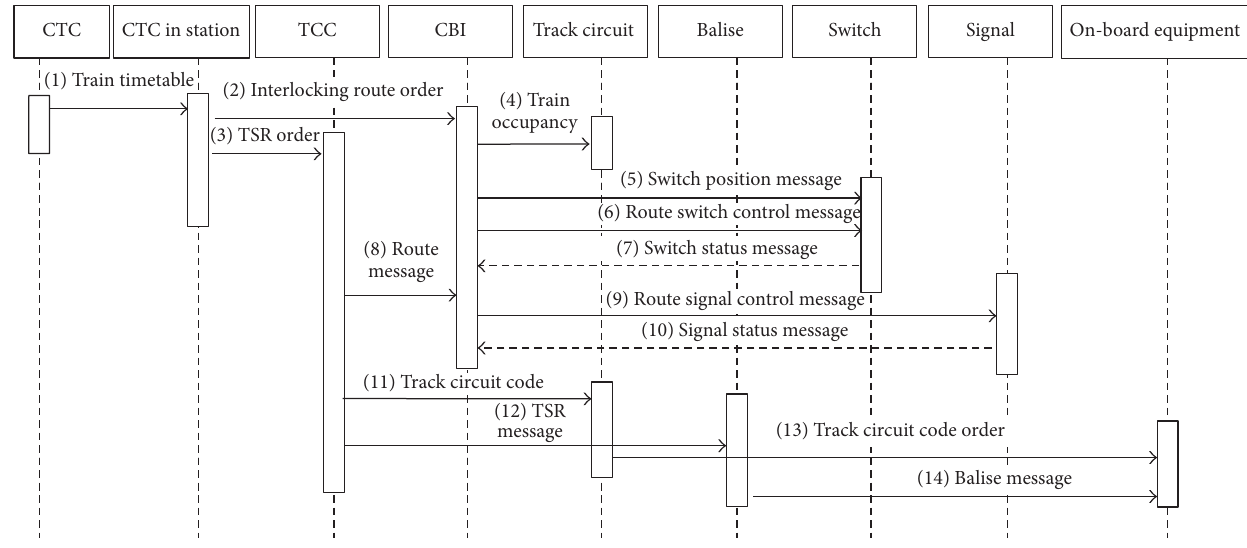
Figure 3: Sequence chart of information interaction for building route in